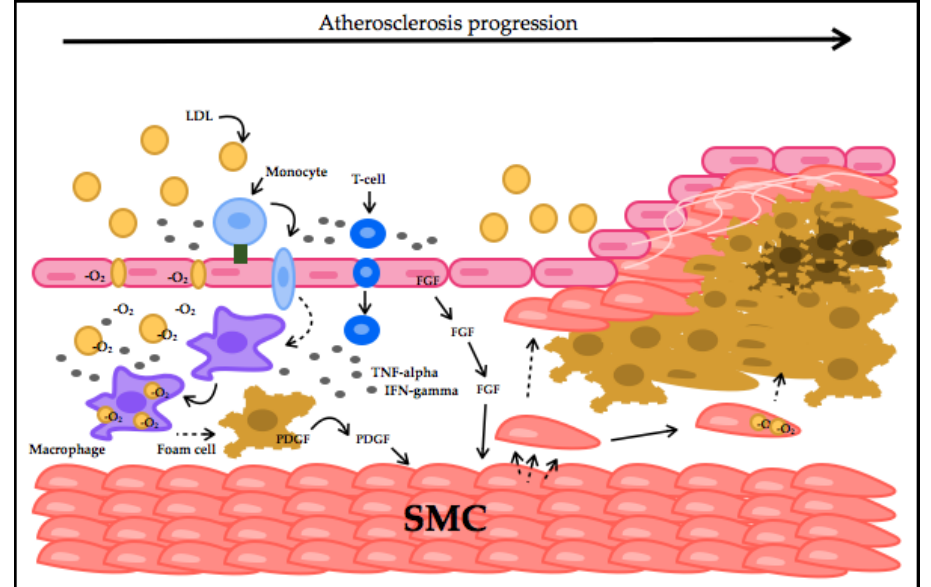
Figure 1. Atherosclerotic plaque formation process. LDLs at a high concentration inhibit endothelial cells’ (EC) endocytosis capacity, migrate and accumulate in the intima. LDLs get oxidized and induce